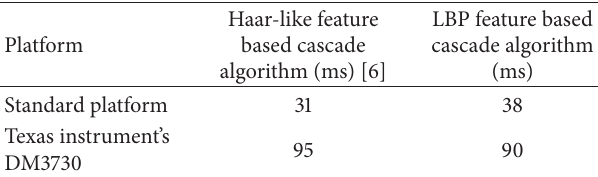
Table 2: Consumed time for each platform.